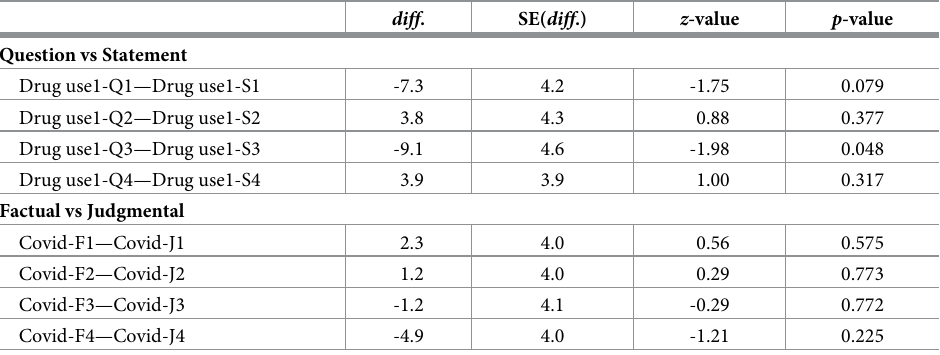
Table 3. Comparison between question formats across ECWM condition.